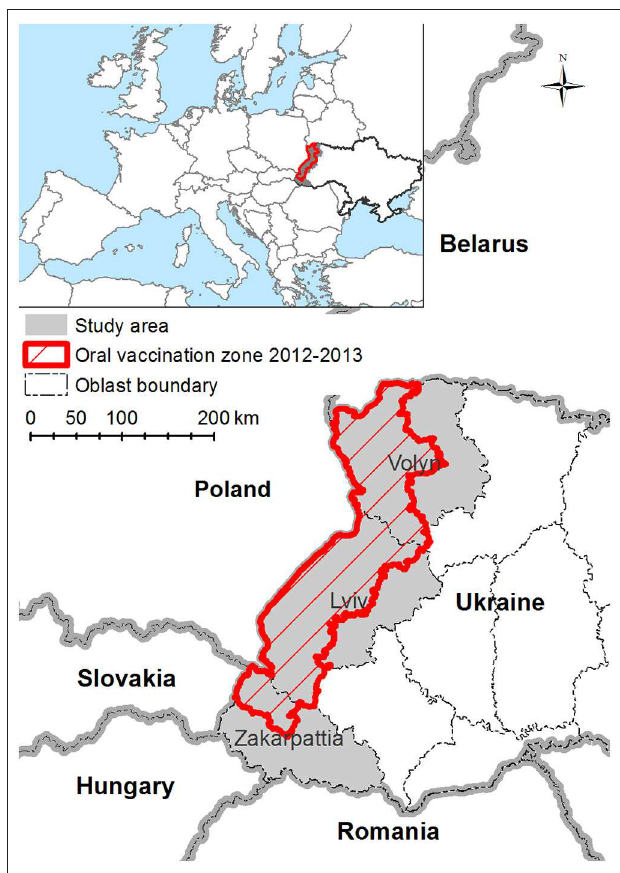
FIGURE 1 | Map of study area—Volyn, Lviv, and Zakarpattia oblasts of Ukraine. Study area is marked with gray fill. Red shaded area is a territory where Ukraine performed the oral vaccination in years